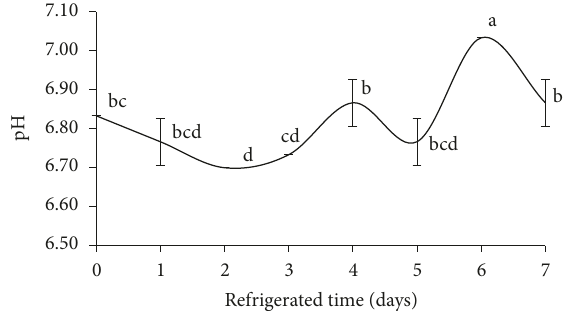
Figure 2: pH of biofluids of Euthynnus affinis upon storage at 4 ∘ C for seven days. Values are means ± SD ( n = 3). Different superscript letters indicate significant differences ( 𝑝 < 0.05